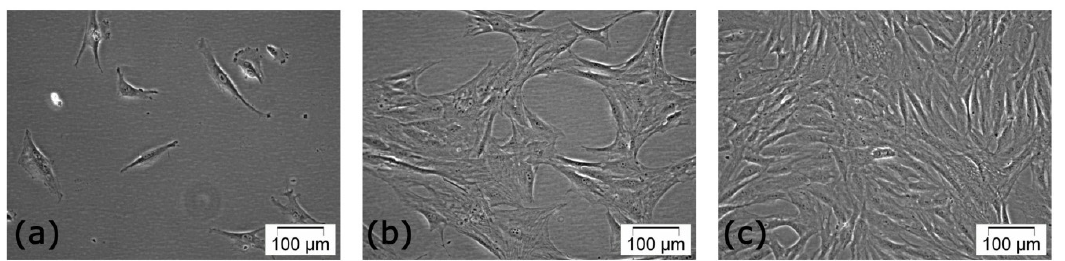
Figure 1. Phase contrast micrographs of cells in primary culture at: ( a ) 24 h; ( b ) 5 days and ( c ) 15 days